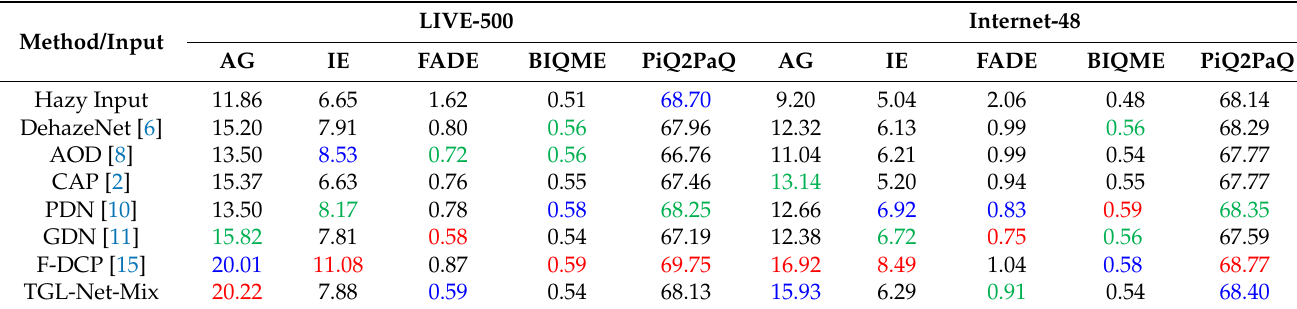
Table 5. Average values of non-reference measures on LIVE and Internet